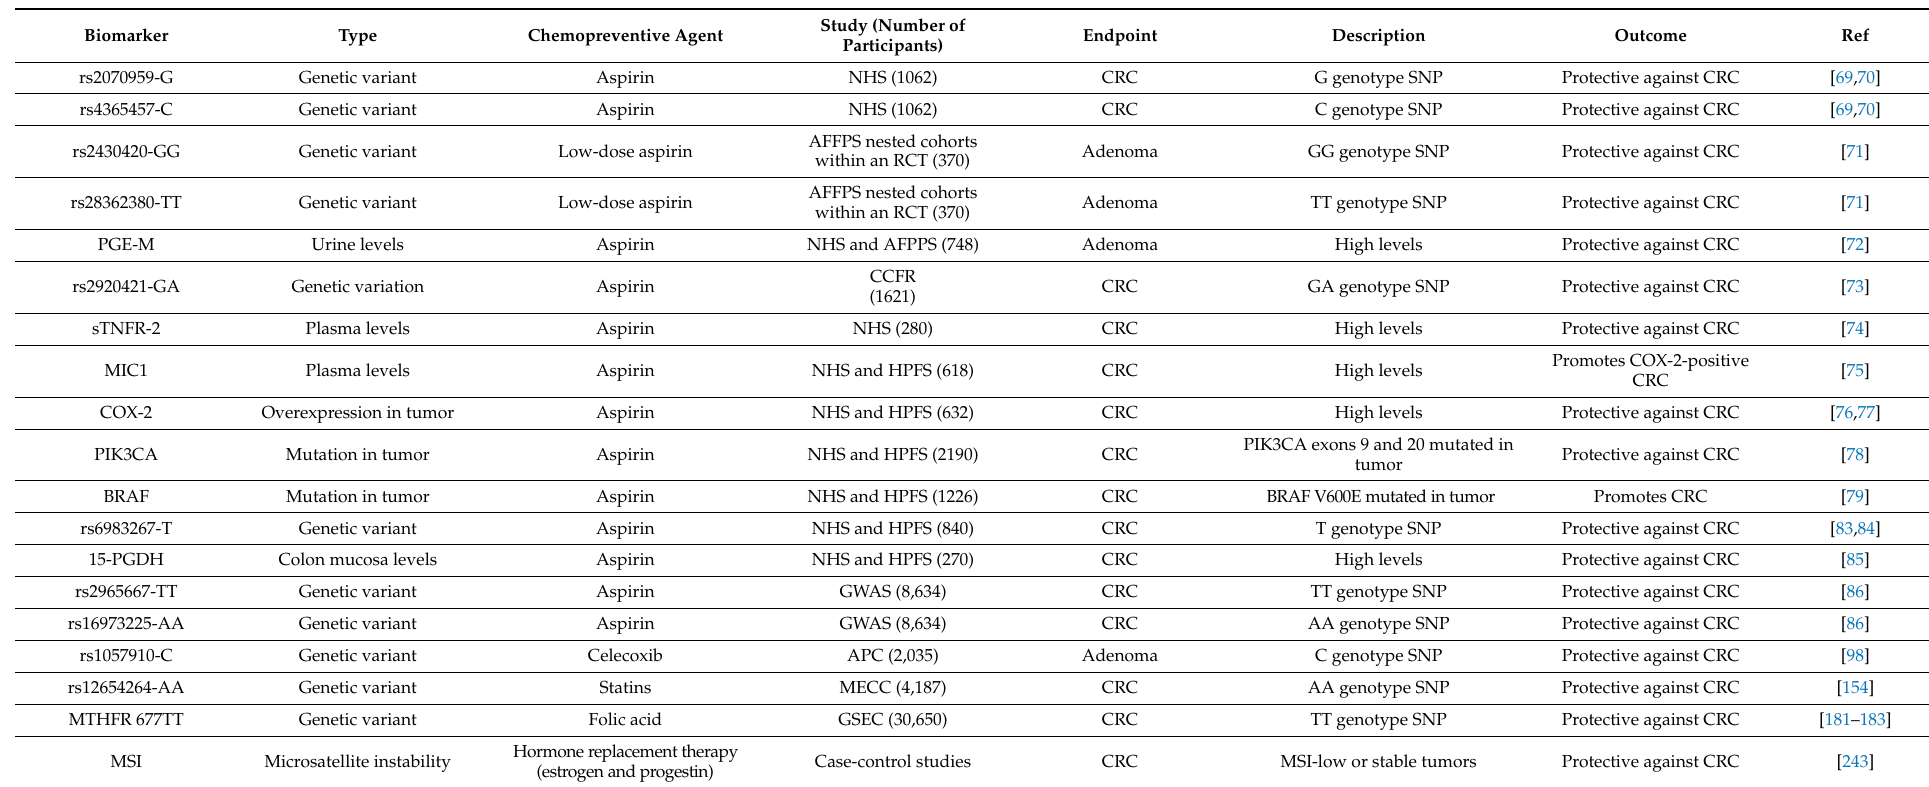
Table 2. Molecular biomarkers associated with CRC chemopreventive agent effects. Abbreviations: 15-PGDH, 15-hydroxyprostaglandin dehydrogenase; APC, Adenoma Prevention with Celecoxib; CCFR, Colon Cancer Family Registry; COX-2, cyclooxygenase 2; CRC, colorectal cancer; GSEC, Genetic Susceptibility